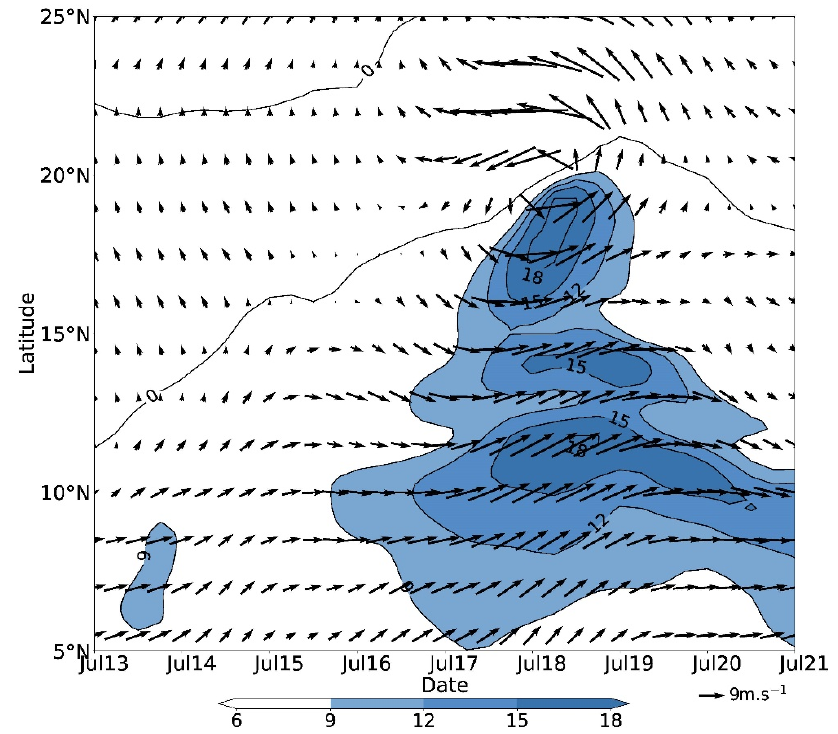
Figure 5. Time-latitude cross section of 850 hPa zonal wind vectors on 111 ◦ E from 13 July to 21 July (units: m s − 1 ; the shading shows the zonal wind greater than or equal to 6 m s − 1 ).